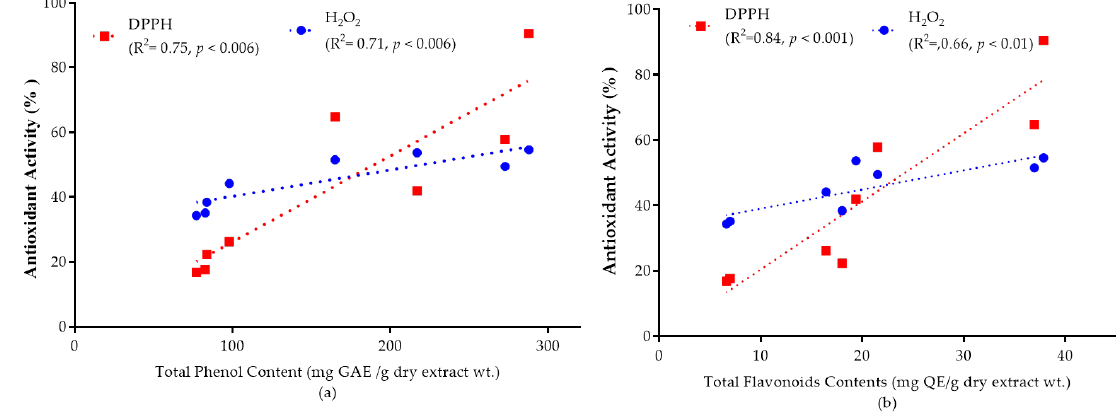
Figure 5. Graphs represent the mean value of antioxidant activity (%) at 50 mg/mL extract solution versus ( a ) total phenolic content and antioxidant activity; ( b ) total flavonoid content and antioxidant activity. The correlation coefficient values for total phenolic (DPPH, R 2 = 0.75; H 2 O 2 , R 2 = 0.71) and total flavonoid contents (DPPH, R 2 = 0.84; H 2 O 2 , R 2 = 0.66) was observed at a 95% confidence level.